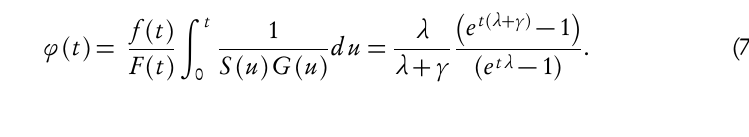
Figure 1 summarizes the results of the simulation study. Assuming exponential dis- tribution for both the event of interest ( λ = 1 / 365) and censoring ( γ = 1 / 365) we sim- ulated 1000 observations. A survival curve was fitted to the data and its variability was estimated with the Greenwood